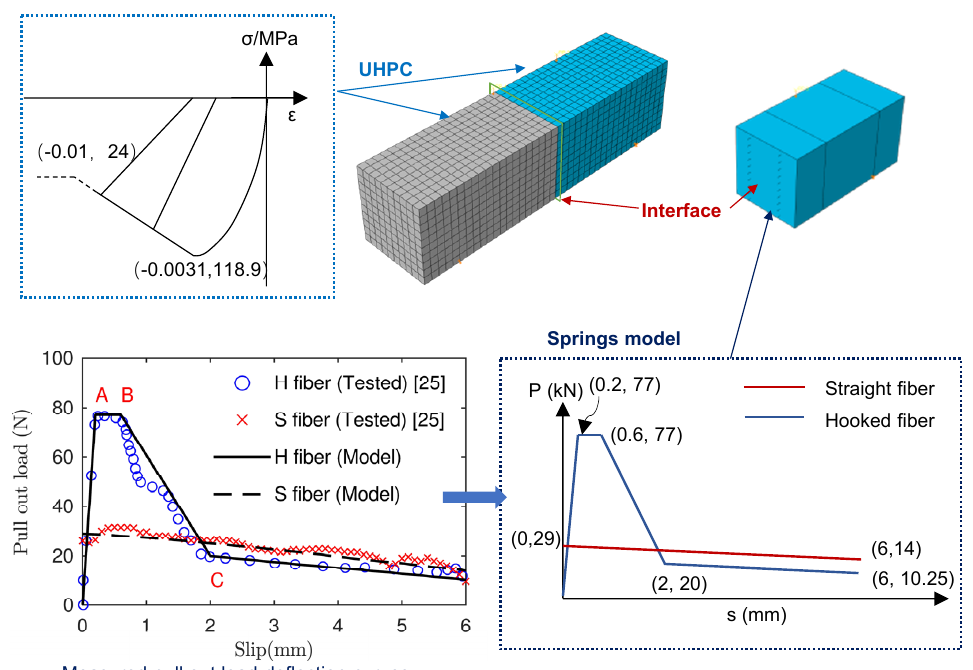
Figure 12. Numerical model of the tested specimens using ABAQUS